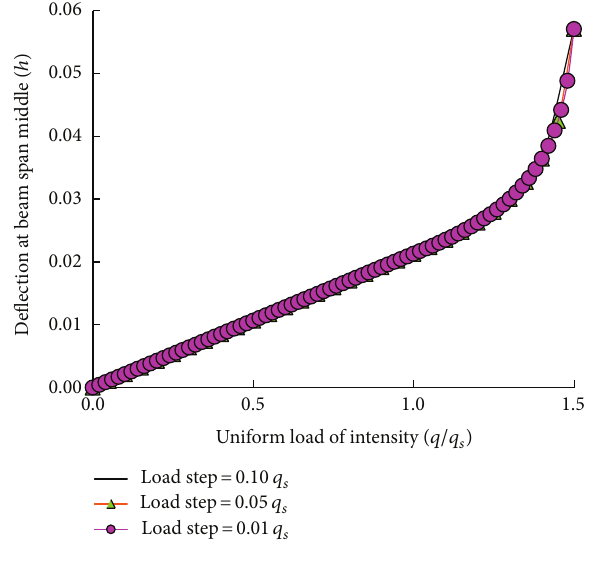
Figure 5: Stability analysis of IDIA.